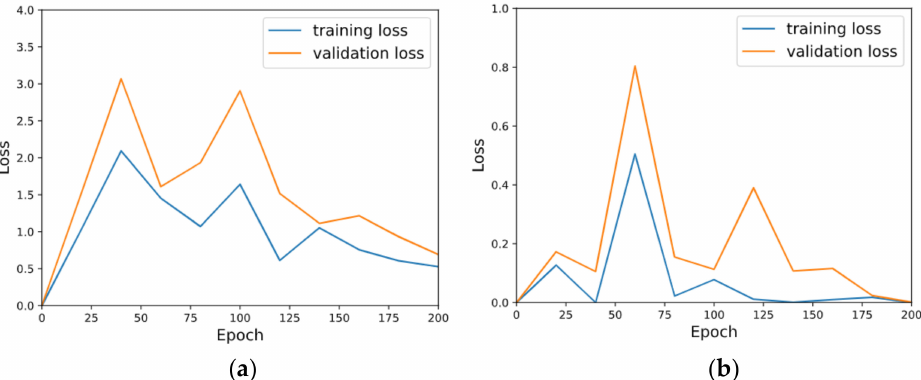
Figure 8. Training and validation loss graphs. ( a ) Training and validation loss graph of attention-guided generator of SI-AGAN and ( b ) training and validation loss graph of attention-guided discriminator of